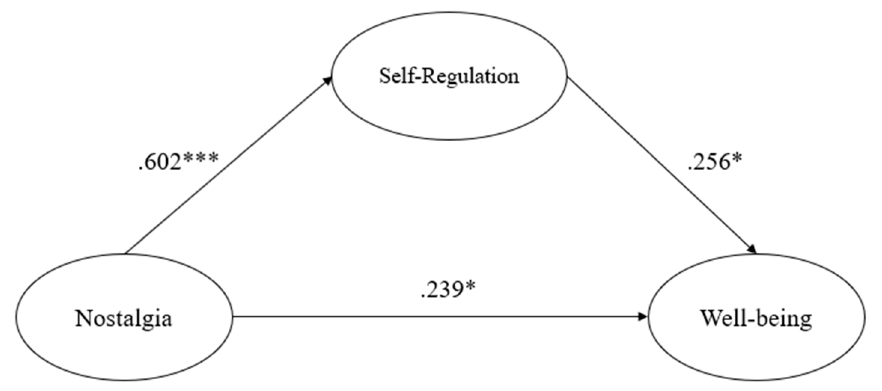
Figure 1. Standardized coefficients of the structural equation model (Note. * p < 0.05; *** p < 0.001).